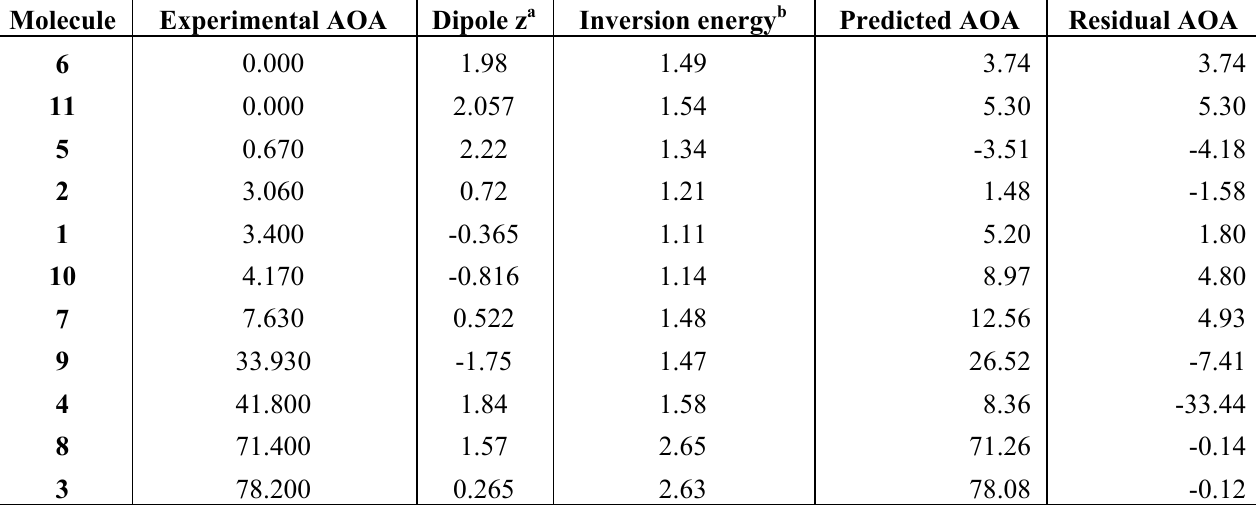
Table 2 . Data obtained with the model generated with basis set of molecules from 1 to 11.